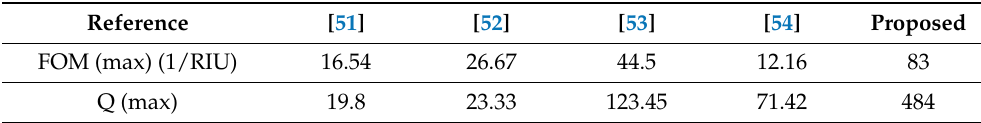
Figure 6. ( a ) The numerical calculation results of the absorption spectrum when the RI of the environment changes. ( b , c ) Linear relationships between the resonance wavelength and the RI in the λ 1 and λ 2 modes, respectively. Table 1. Comparison of the maximum FOM and Q value of the absorber reported in this paper with the results of the dual-band absorber reported by other works.